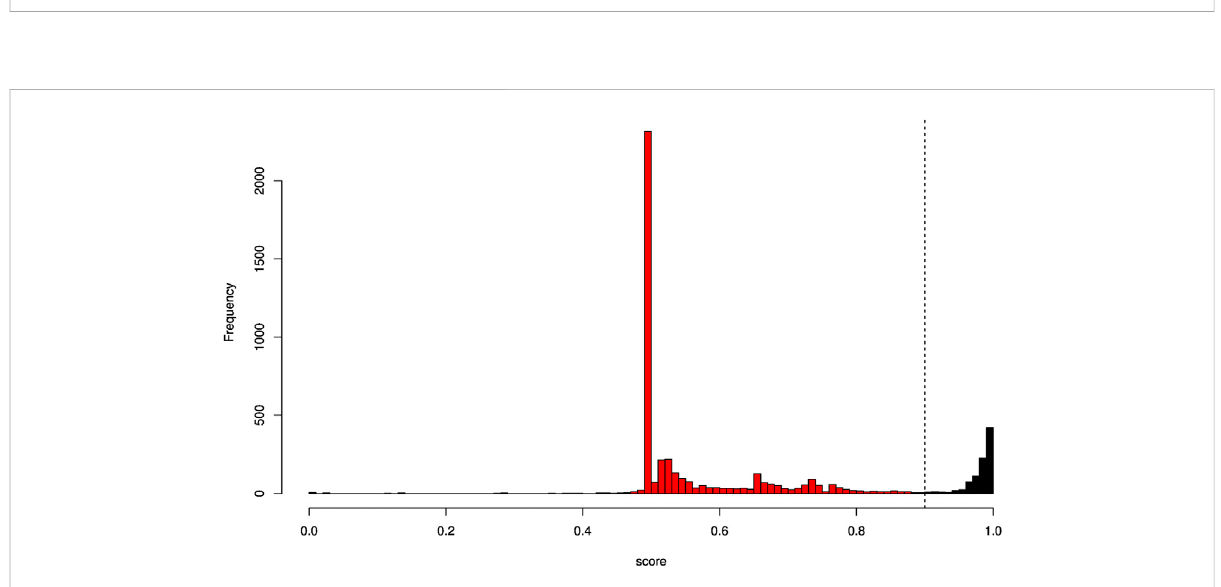
FIGURE 3 HistogramofSNPdiscriminatingscore.The x -axisrepresentsthescorevalues;the y -axisrepresentstheabsolutefrequencyofSNP.Thevertical dotted line indicates the threshold (0.9) considered to de fi ne an SNP as discriminant. SNPs whose scores were higher than 0.9 were conserved and quali fi ed as discriminant (in black). SNPs with scores less than or equal to 0.9 (in red) were